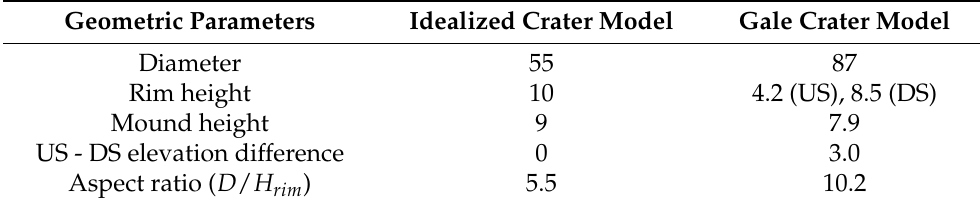
Table 3. Geometric properties of the idealized crater model and of Gale Crater model. The abbrevia- tions US and DS refer to the upstream and downstream sides, respectively. All physical units are in